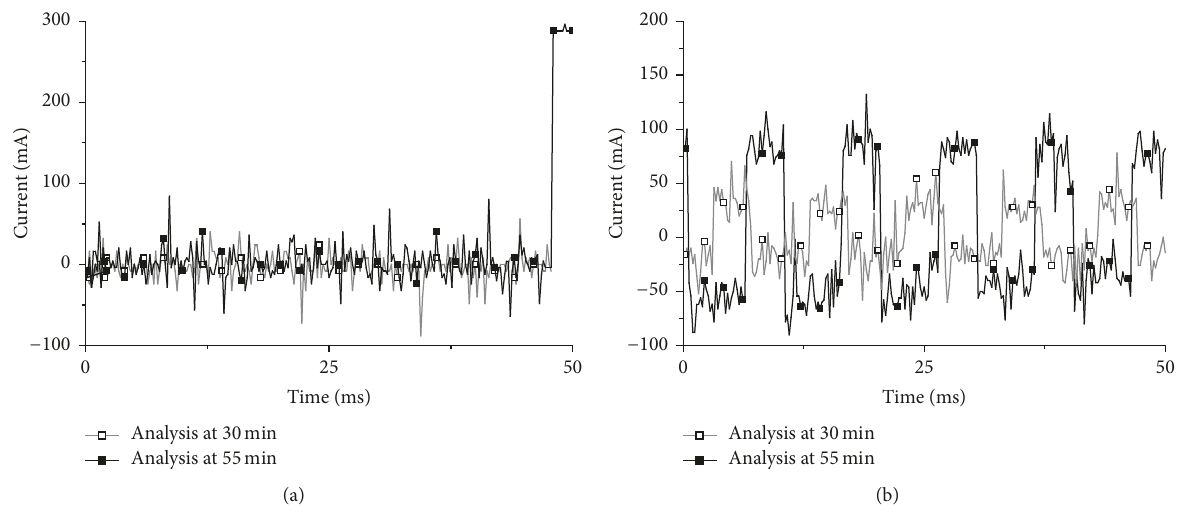
Figure 1: Oscilloscope data for pulsed current anodisation of 60 min on titanium surfaces: (a) electropolished and (b) nonelectropolished